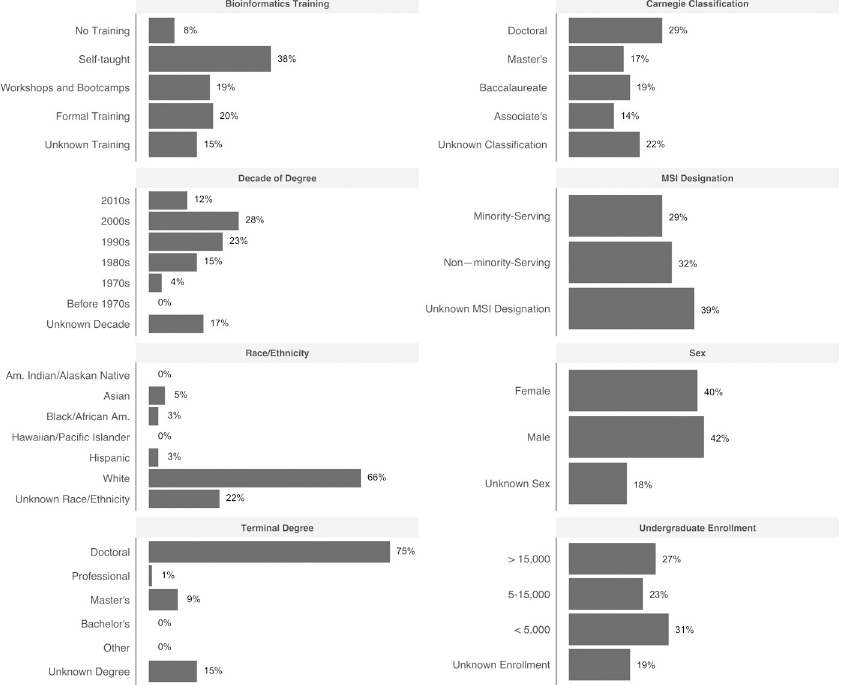
Fig 1. Summary demographics. Summary demographics shown as percentages of respondents ( n = 1,231, the total number of US respondents). The composite survey respondent is a white male or female PhD, self-taught in bioinformatics, with their degree earned in 2000–2009. S/he works at a non-minority-serving, doctoral-granting institution with an undergraduate enrollment of less than